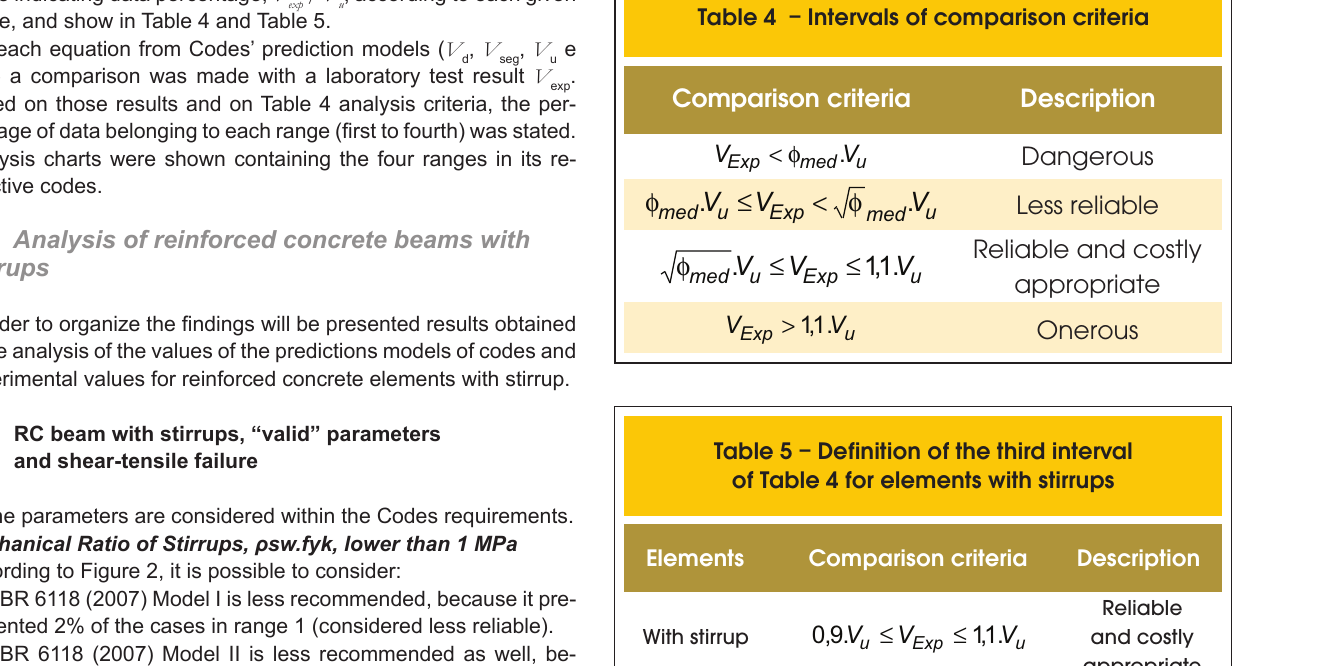
Table 4 – Intervals of comparison